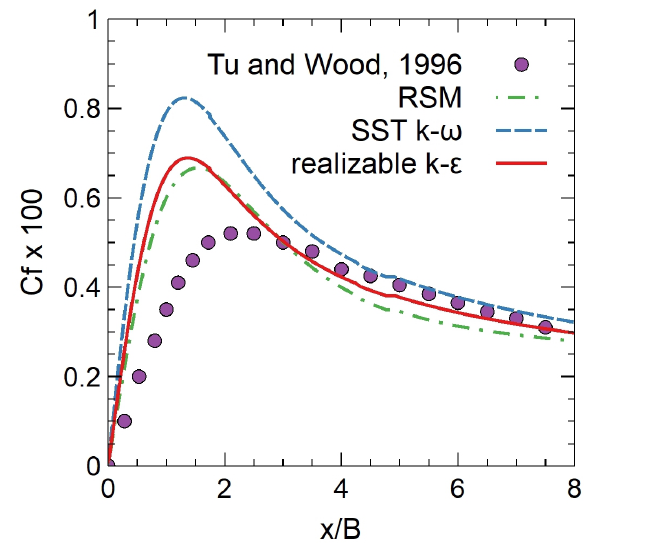
Figure 9. Skin friction coefficient profiles for H / B = 12, compared to reference results reported by Tu and Wood